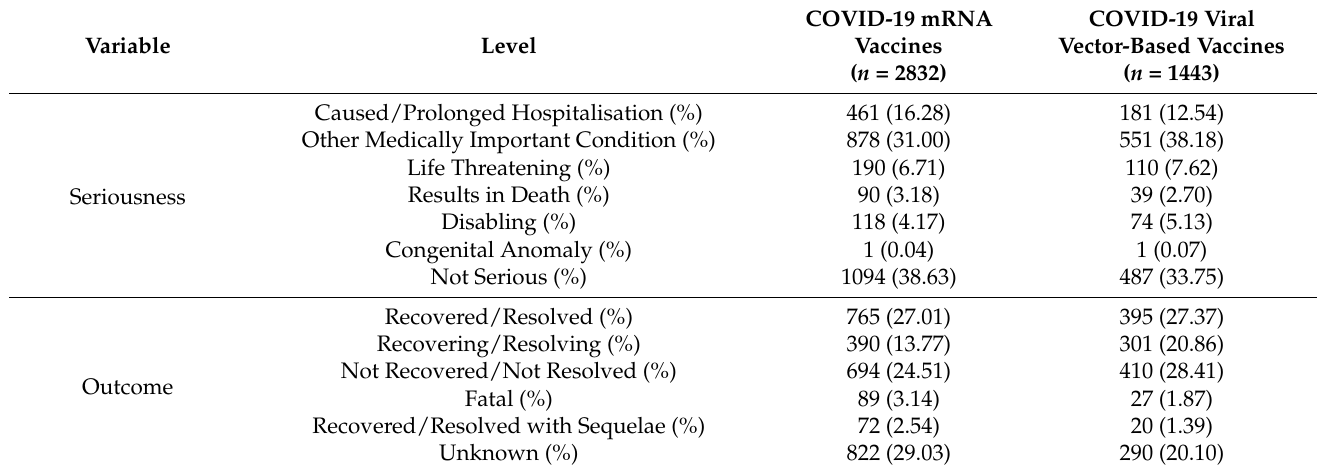
Figure 1. Distribution of impaired glucose metabolism events. Percentages of reporting impaired glucose metabolism events for groups (“diabetes in pregnancy”, “acute complications of diabetes”, “pre-diabetes”, “type 1 diabetes mellitus”, “type 2 diabetes mellitus”, “high glucose levels”, “diabetes mellitus inadequate control”, “diabetes mellitus not specified”, and “hypoglycaemia”) and type of COVID-19 vaccine (Pfizer-BioNTech, Moderna, Oxford–AstraZeneca, and Janssen vaccines) reported in Eudravigilance from 1 January 2021 to 11 December 2021. Table 3. Seriousness and outcome of impaired glucose metabolism events distributed by mRNA or viral vector-based COVID-19 vaccines and reported in Eudravigilance from 1 January 2021 to 11 December